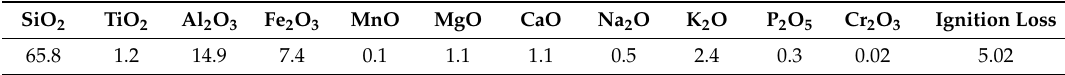
Table 2. Mineralogical composition of the earth studied by X-ray diffraction. Quartz Smectite Illite Kaolinite